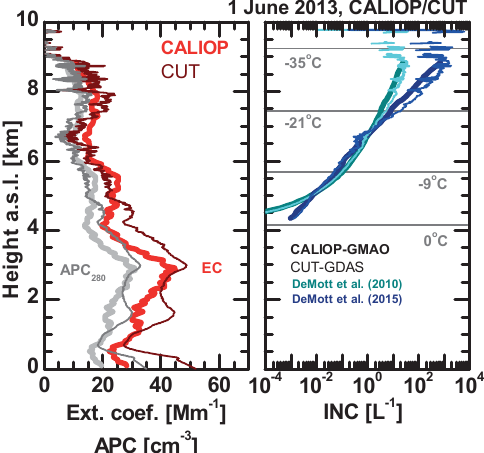
Figure 10. Profiles of 532nm desert dust extinction coefficient σ d , APC 280 , and INC. GDAS profiles of temperature and pressure for the Limassol region were used in the CUT lidar data analysis (thin lines) and GMAO Data Assimilation System profiles of the meteo- rological parameters along the CALIOP flight track were used in the analysis of the space lidar observations (thick lines). INC profiles computed with Eq. (2) (DeMott et al., 2010) are shown as light blue lines (CALIOP, thick, CUT lidar, thin). INC profiles computed with Eq. (3) (DeMott et al., 2015) are shown as dark blue lines (CALIOP, thick, CUT lidar, thin). Grey horizontal lines indicate the tempera- ture ranges for which the parameterizations are explicitly valid ( − 9 to − 35 ◦ C, Eq. (2), − 21 to − 35 ◦ C, Eq. (3)). Uncertainties are on the order of 20% (for σ d ), 30% (for APC 280 ), and within a factor of 3 (in the case of INC) when using the dust INC parameterization after DeMott et al.